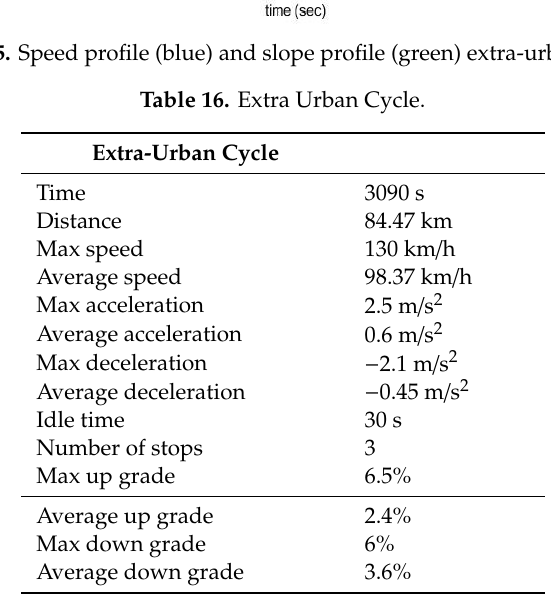
Figure 5. Speed profile (blue) and slope profile (green) extra-urban cycle.